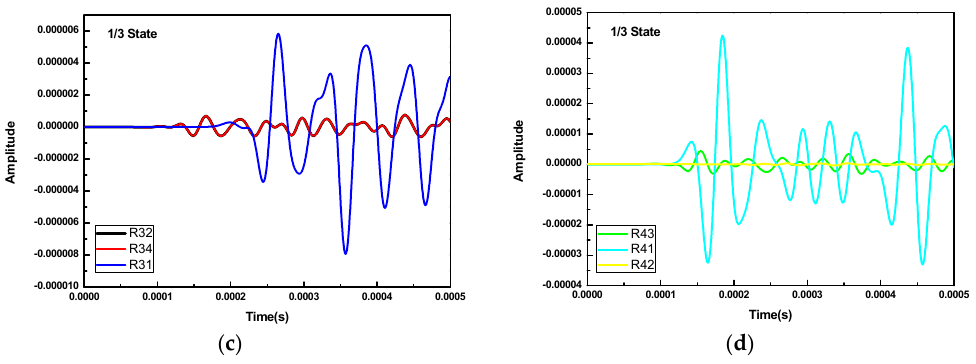
Figure 5. The waveforms of cross-excitation: ( a ) the 2/3 concrete infill condition, excited by R3; ( b ) the 2/3 concrete infill condition, excited by R4; ( c ) the 1/3 concrete infill condition, excited by R3; ( d ) the 1/3 concrete infill condition, excited by R4.